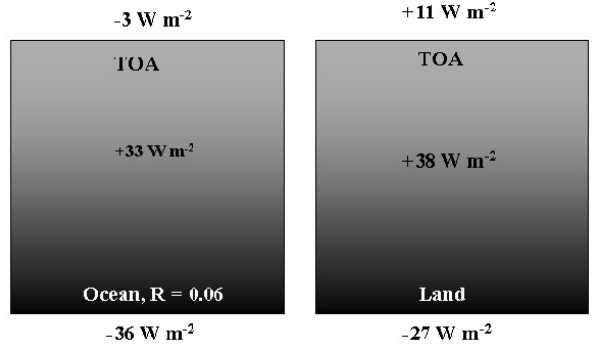
Fig. 2. The effect of doubling the soot contribution to aerosol op- tical depth and to aerosol radiative forcing. Here the land was as- sumed as a combination of 70% soil and 30%